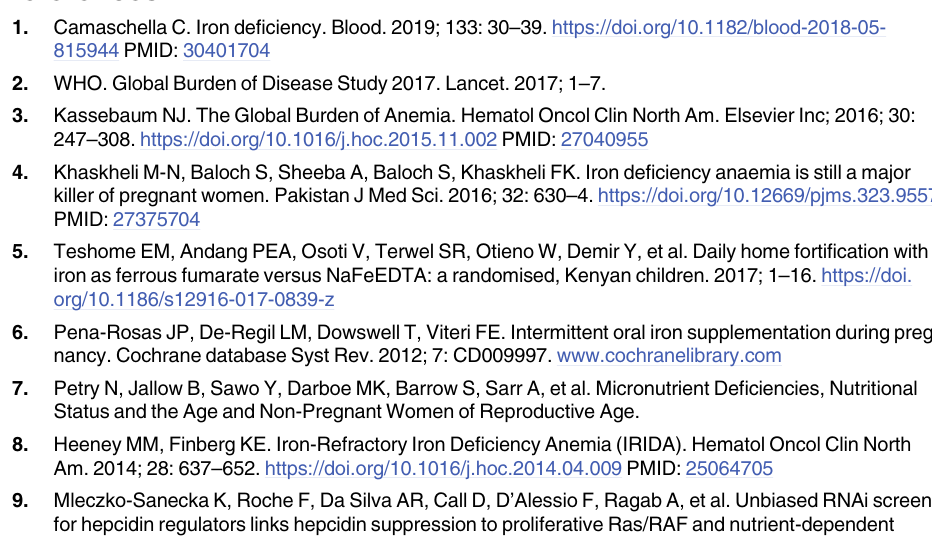
S4 Table. Genotyping data for 13 SNPs for the Gambian population in the Keneba Bio-